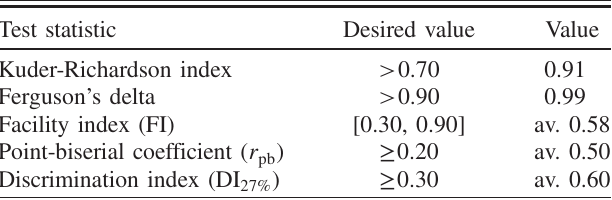
TABLE IV. Summary of the values of the five statistical indices used to assess test reliability.